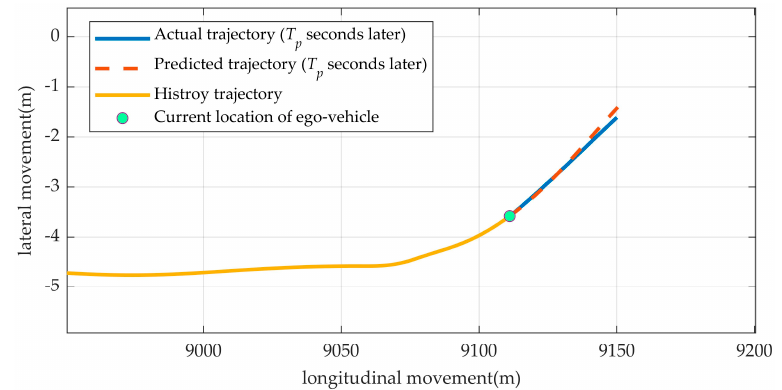
Figure 4. An example of a predicted target trajectory (in T p later).